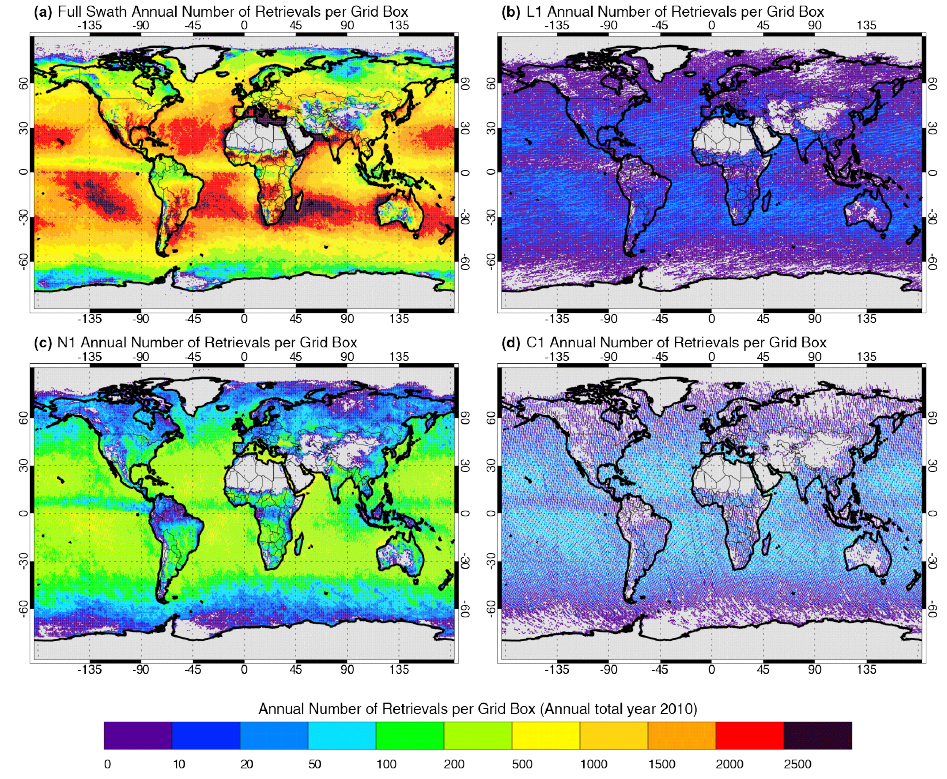
Figure 6. Number of MODIS Aqua AOT retrievals made per 0 . 5 ◦ × 0 . 625 ◦ grid box for the entire year 2010 as used to compose the (a) full-swath annual mean shown in Fig. 3a and for the (b) L1, (c) N1, and (d) C1 sub-samples. Light grey shading indicates locations where no retrievals were